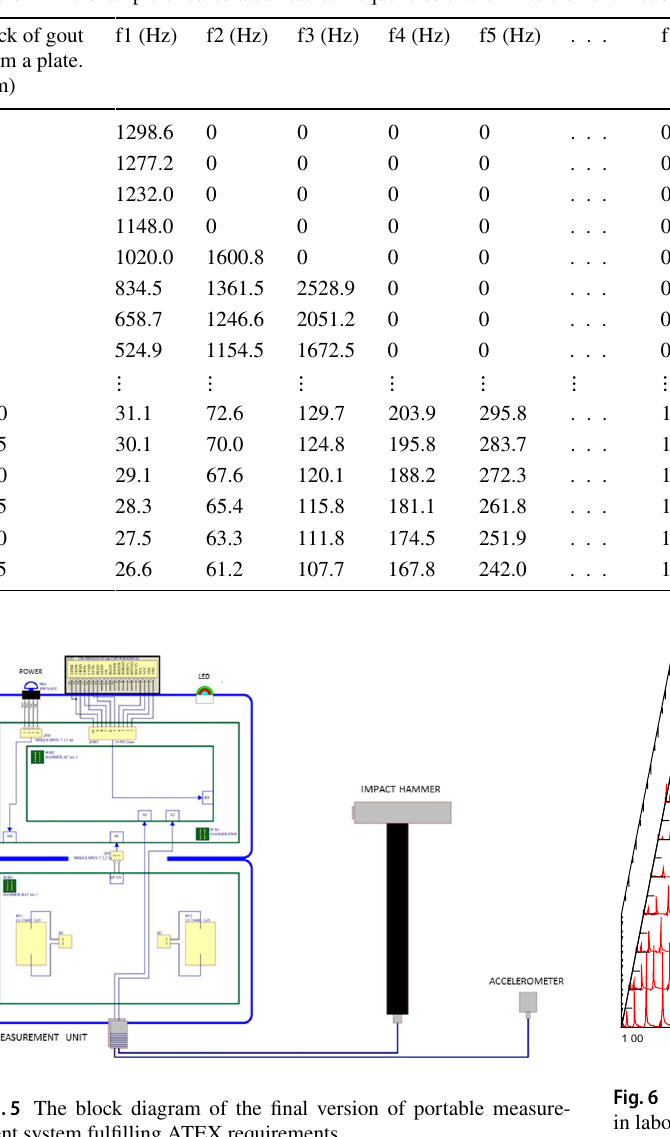
Fig. 5 The block diagram of the final version of portable measure- ment system fulfilling ATEX requirements